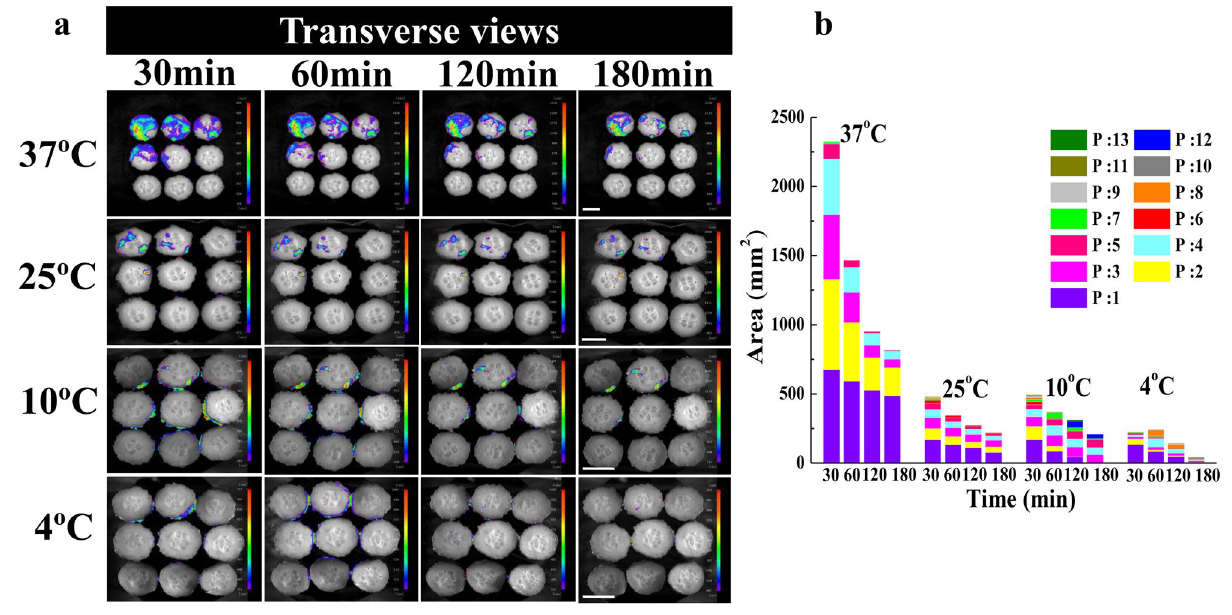
Figure 2. BL images of the transfer and distributed of E. coli on the cucumber slices under different storage temperatures and times. ( a ) The first row of cucumber slices from left to right represented cut numbers of 1, 2, 3; the second row represented 4, 5, 6; the third row represented 7, 8, 9. The scales are the same under the same temperature. All scales represent 3 cm. ( b ) The bar graph showed the contaminated area of E. coli on cucumber slices after cutting under each storage condition. Different contaminated areas were indicated by different colors. IndiGo software (https:// www. nchso ftware. com/ accou nting/ index. html? kw= sage% 20soft ware & gclid= AIaIQ obChM I3MvFj- zr7wI Vj2gq Ch14f AmLEA EYASA AEgJP qPD_ BwE, https:// softw areto pic. infor mer. com/). OriginPro 8 software (https:// en. freed ownlo adman ager. org/ users- choice/ Origin_ 8_ Free_ Downl oad_ Full_ Versi on. html, https:// softw areto pic. infor mer.